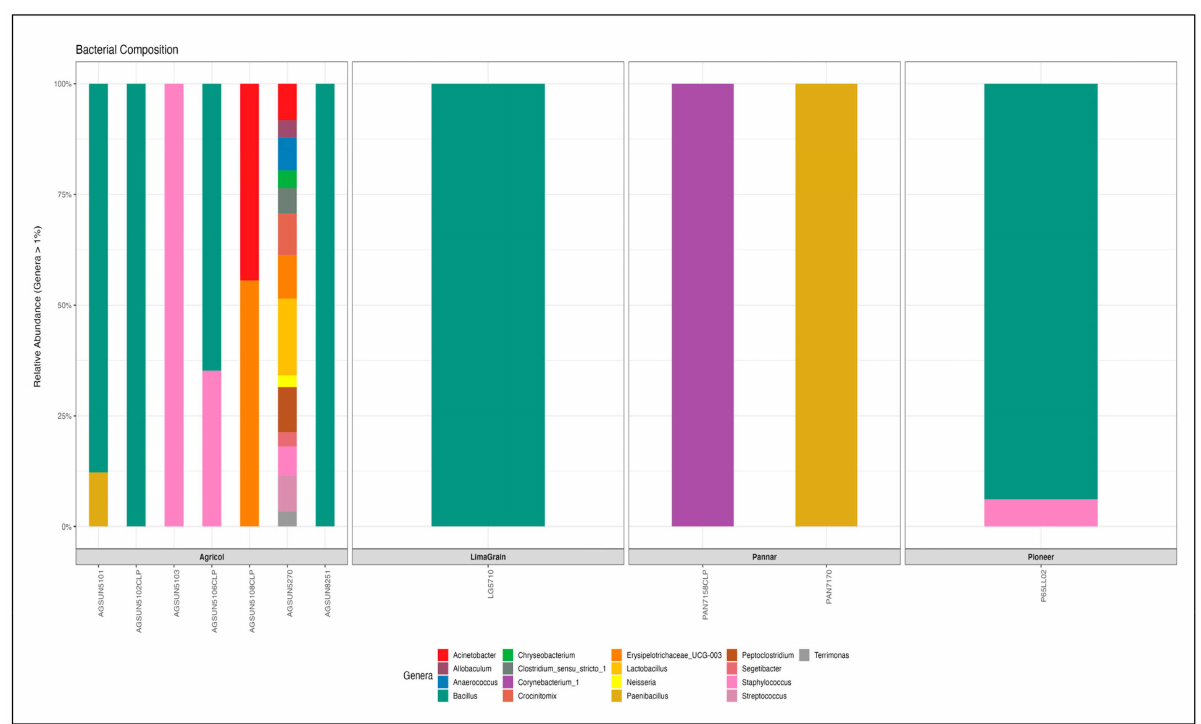
Figure 10. Relative abundance of the dominant bacteria Genera from different cultivars of South Africa H. annus seeds. Bacillus appeared in 7 of the cultivars, with the highest abundance in most. Interestingly, AGSUN5270 was the only cultivar with the highest degree of bacteria diversity, with 14 genera of bacteria community.